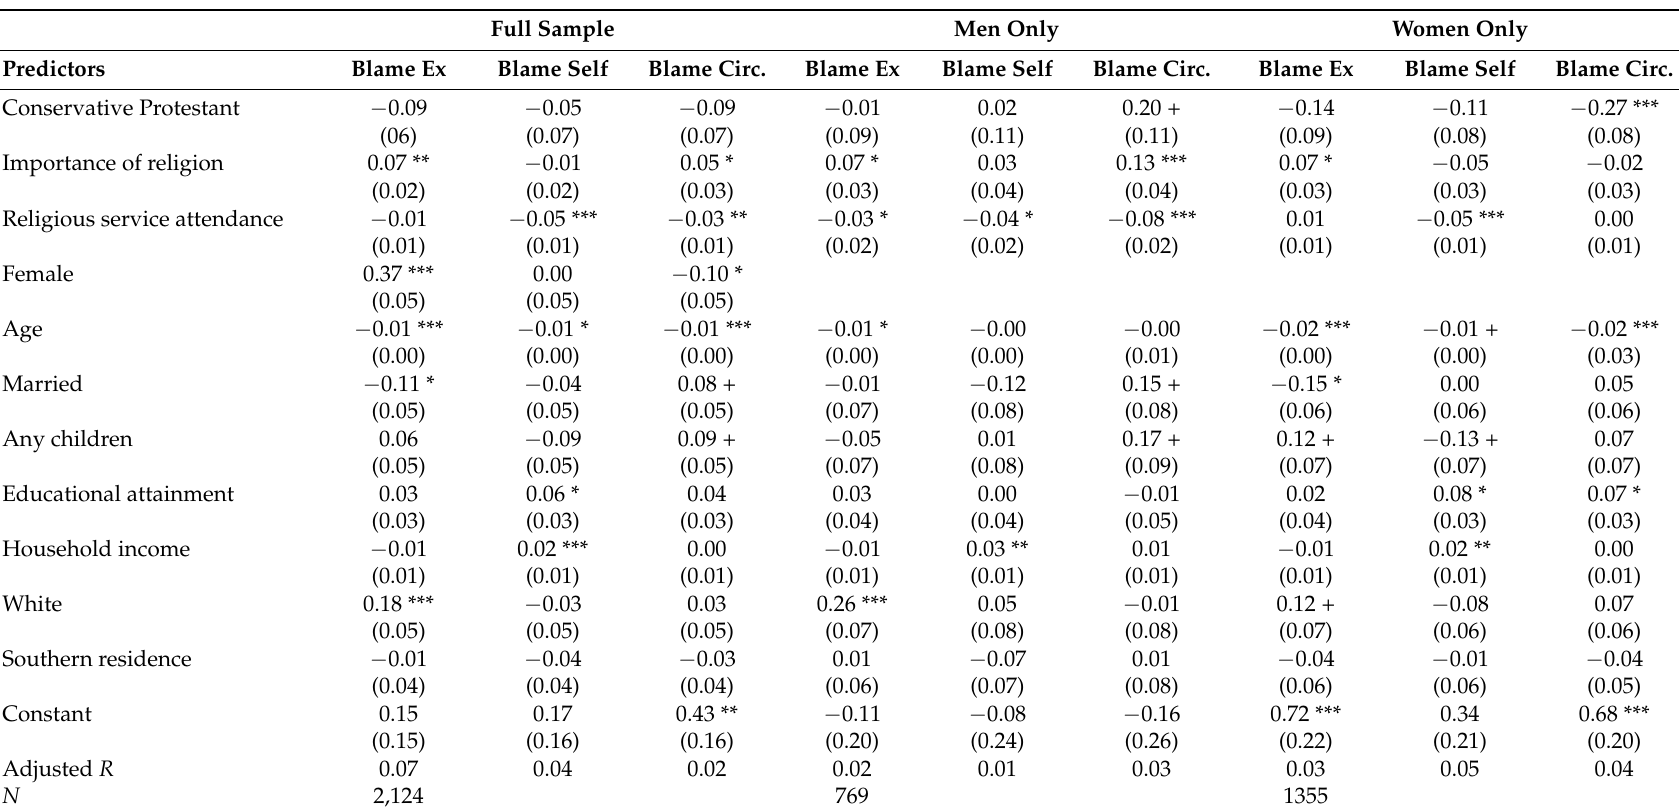
Table 5. Ordinary least squares regression predicting whether respondents are more likely to affirm reasons that mostly blame their former spouse, themselves, or other circumstances for their